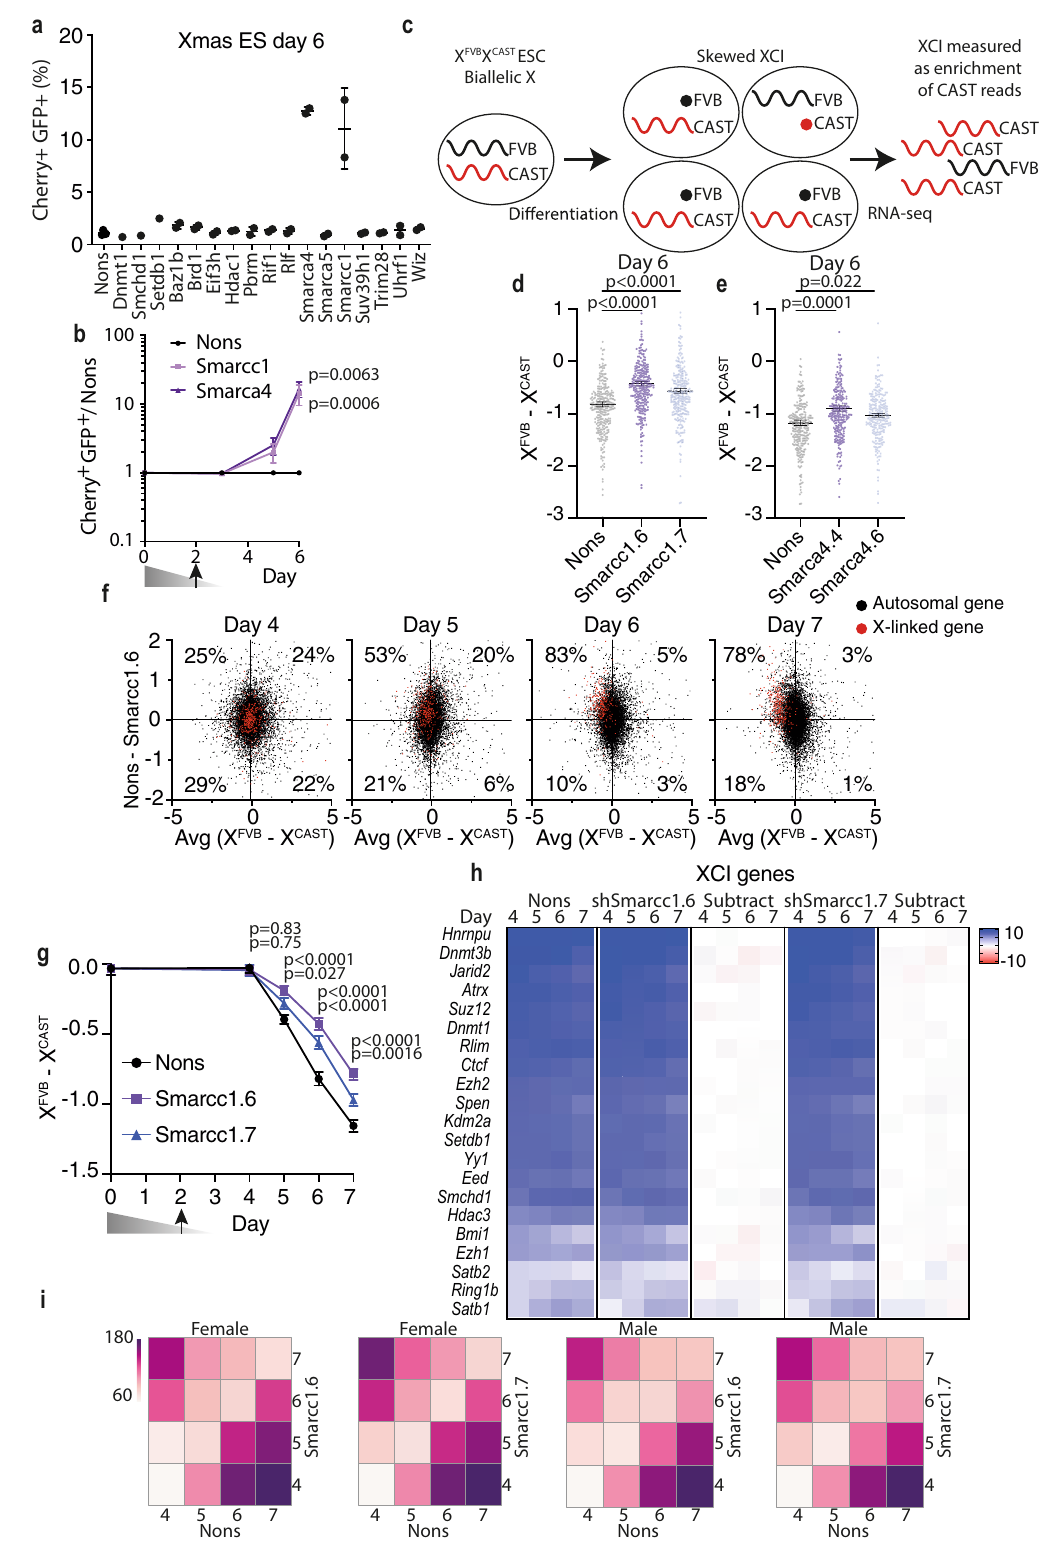
Smarcc1 or Smarca4 depleted cells (Supplementary Fig. 5e, f). This timepoint is akin to day 4 of differentiation in Xmas mESCs with endogenous Xist . When measured by qRT-PCR, Xist levels were normal following 24 h of continual doxycycline driven expression in control and depleted cells (Supplementary Fig. 5g). To determine Xist ’ s ability to spread and establish XCI,